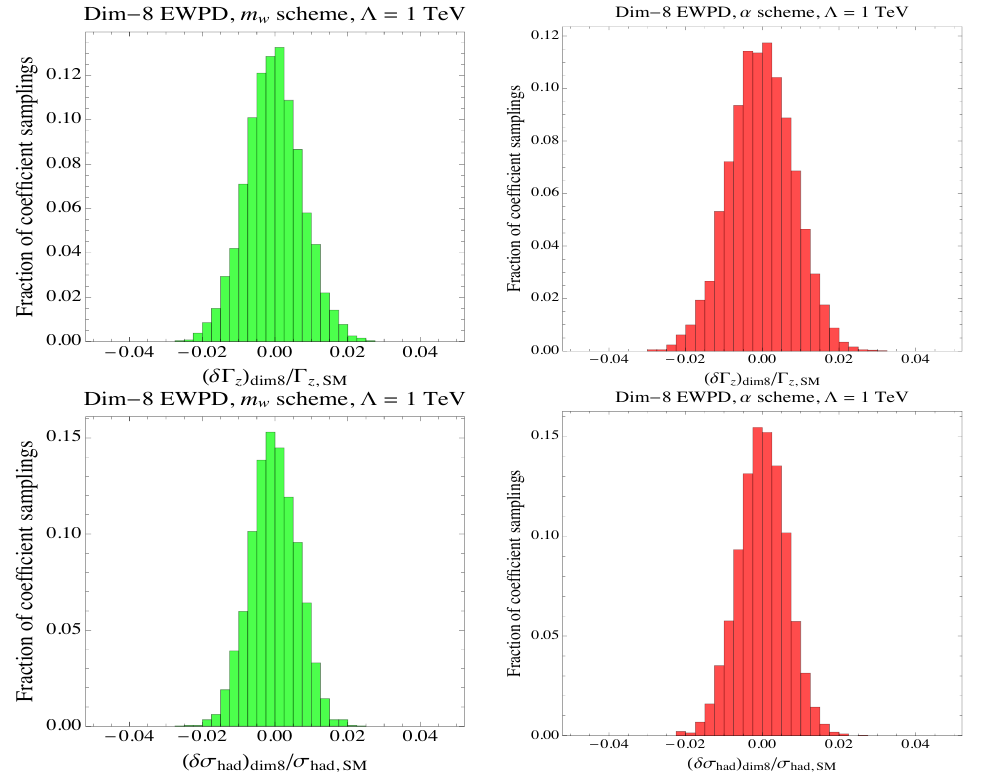
Figure 14 . Contributions to the Γ Z and σ 0 from dimension-eight operators relative to the SM had value. Here Λ = 1 TeV. The histograms are formed from selecting random values for the coefficients 5000 times following the scheme described in the